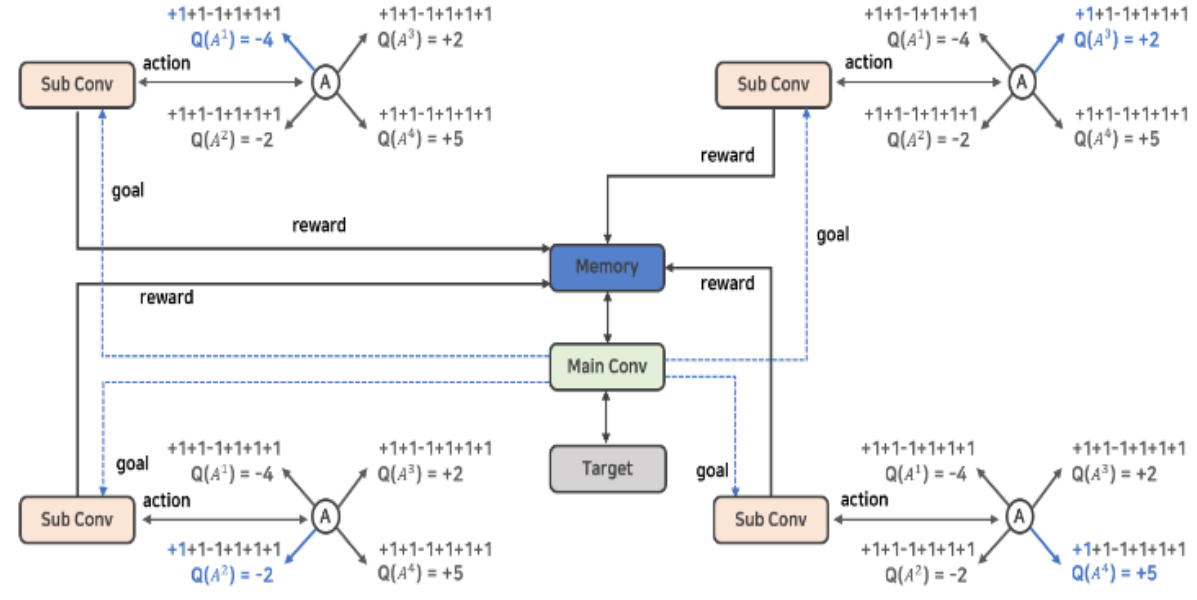
Figure 4. Architecture of the proposed multi-agent N-DQN.